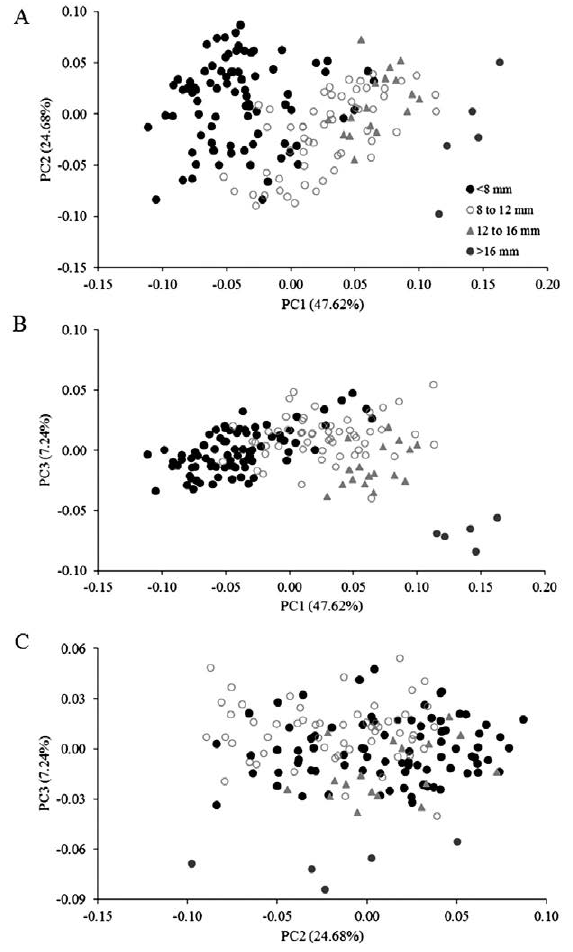
Fig. 2. – Principal component analysis: the principal morphometric changes axes during ontogenetic development of S. sanguineus